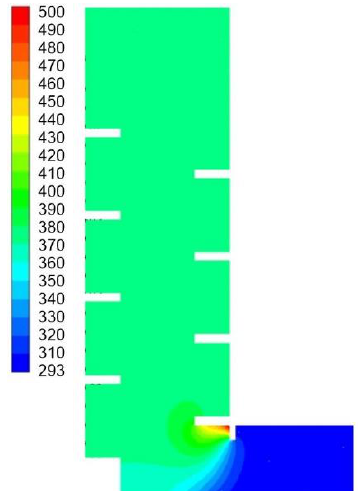
Figure 11. Carbon dioxide distribution in the staircase before ( left ) and after ( right ) axial fan appli- cation. Carbon dioxide was measured as a mass fraction.